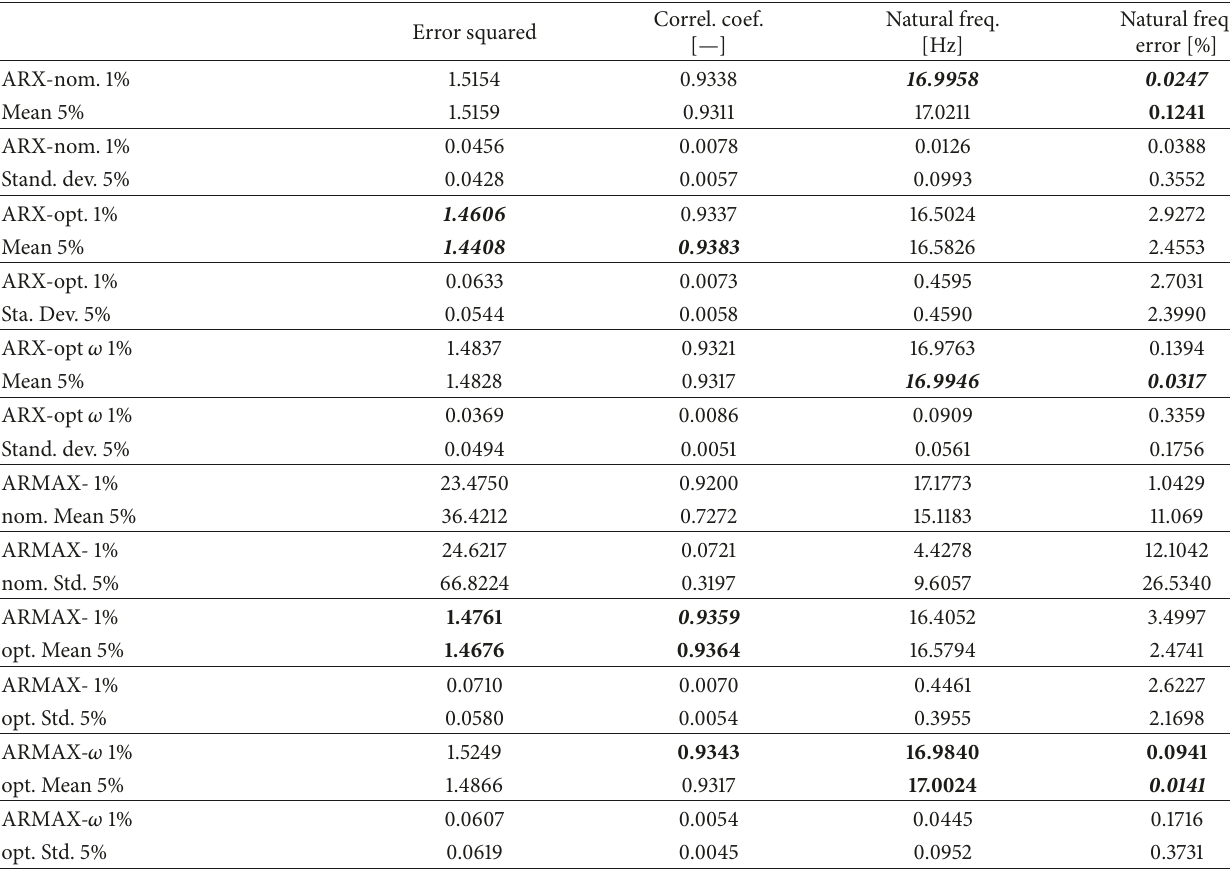
Table 2: Simulation results with 1% and 5% noise std.